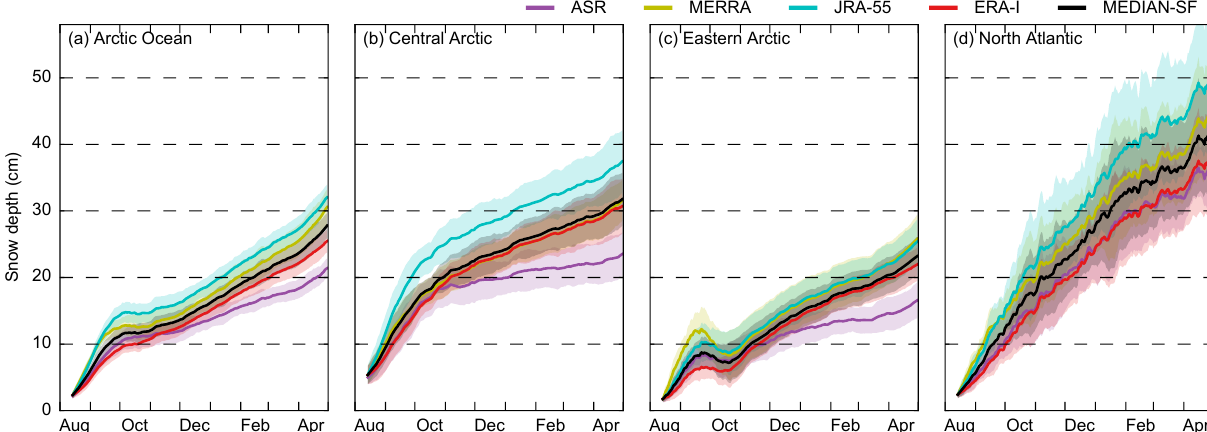
Figure 9. Seasonal snow depth evolution across the four study regions (shown in Fig. 5) initiated from 15 August 2000 to 2014 and run until 1 May of the following year, forced by five different reanalysis snowfall products. This figure also includes results using the ASRv1 forced simulations (which are limited to 15 August 2000 to 1 May 2012). The thick lines show the mean (daily) regional snow depths over this time period, while the shaded areas represent interannual variability (1 standard deviation). All model runs use the default forcings/parameter settings.